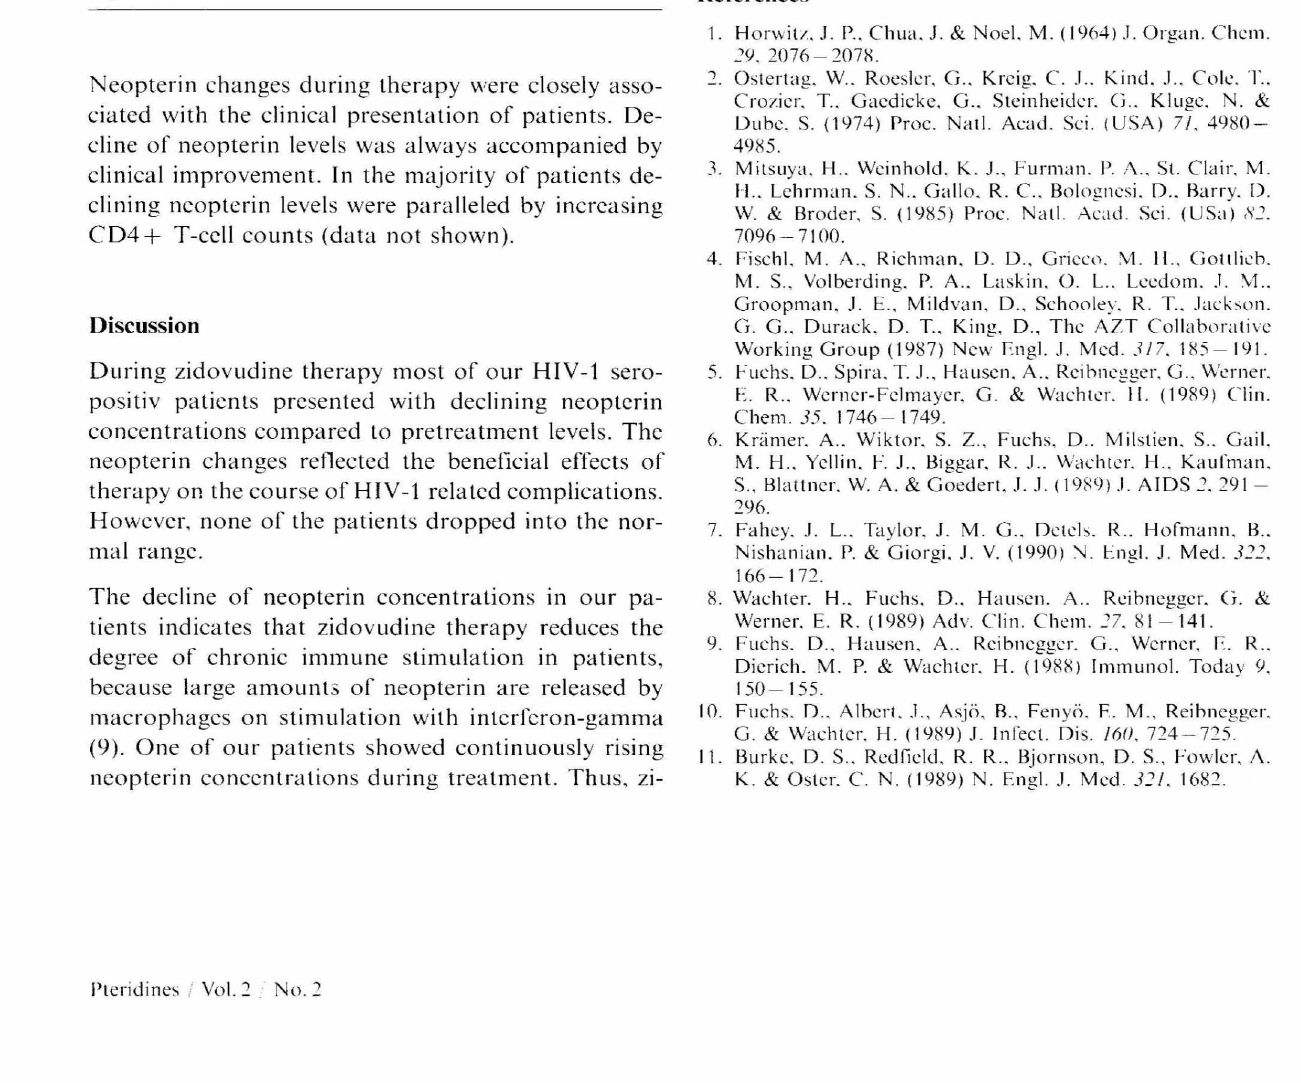
pret rea t mcnt during therapy dllring Iherapr ('Yo)